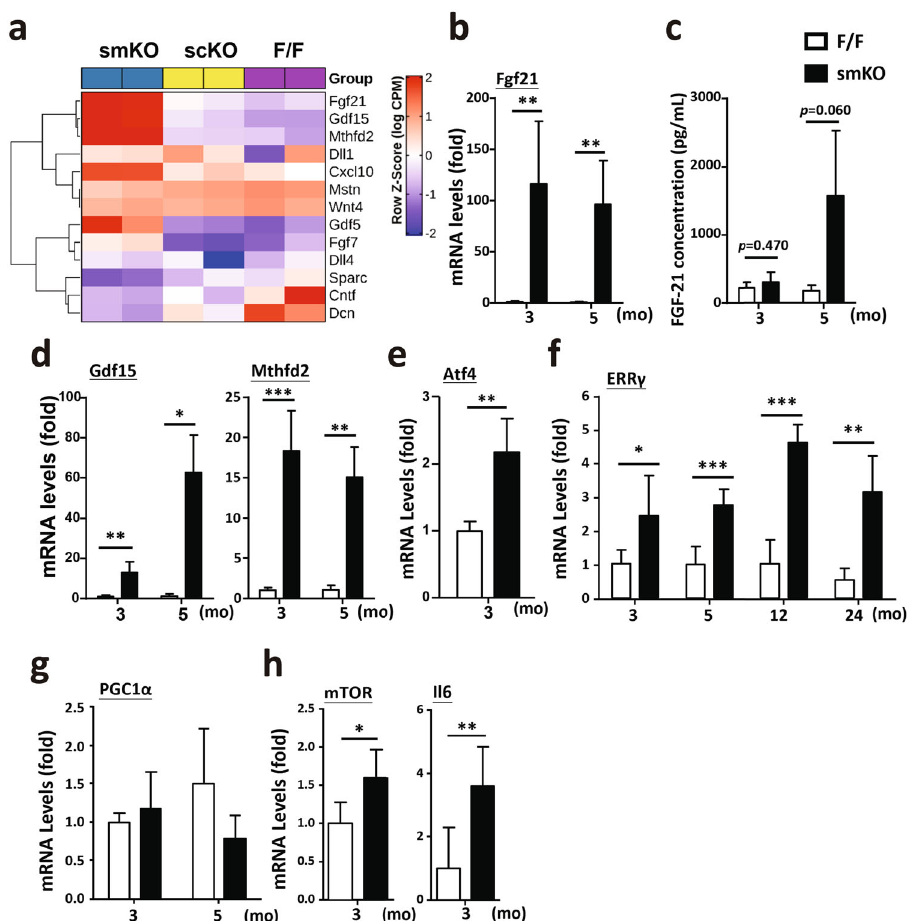
Fig. 6 Myo fi bers modulate stem cell function by myokine secretion. a RNA sequencing data showed the expression of myokines in the gastrocnemius muscle of the Rrm2b smKO, scKO and F/F mice. b mRNA expression levels of Fgf21 were veri fi ed in muscle of the Rrm2b smKO mice. c Fgf21 levels in circulation were determined by ELISAs. d mRNA expression levels of Gdf15 and Mthfd2 were detected in muscle of the Rrm2b smKO mice. e mRNA expression levels of mTOR and Atf4 were detected in muscle of the Rrm2b smKO mice. f Gene expression levels of ERR γ were measured in muscle of the Rrm2b smKO mice at 3, 5, 12, and 24 months of age. g mRNA expression levels of PGC1 α were detected in muscle of the Rrm2b smKO mice. In b – g , six mice were in each group. h mRNA expression levels of mTOR and Il6 were detected in MuSCs isolated from the Rrm2b smKO mice. In h , eight mice were in each group. The results are presented as the mean ± SD. Statistical analysis of differences between the groups was performed by two-tailed, unpaired t-tests, and the P -values were calculated. Asterisks denote statistically signi fi cant changes from the control and are de fi ned as * P < 0.05; ** P < 0.01; *** P <